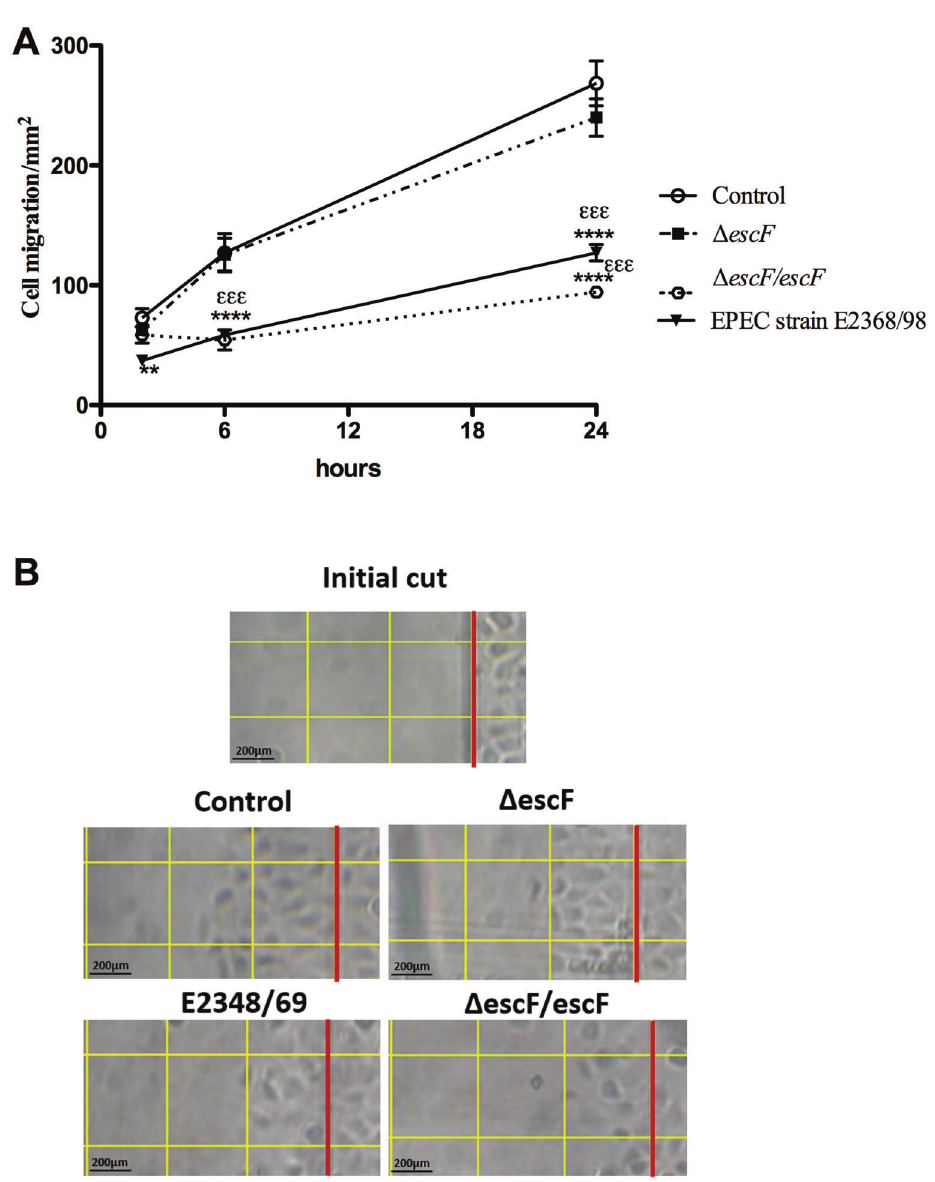
Figure 3. Effects of enteropathogenic Escherichia coli (EPEC) strain E2348/69, EscF-complemented ( D escF / escF ), and type III secretion system (T3SS)-deletion mutant ( D escF ) infection on migration of IEC-6 cells A . Data are reported as mean ± SE of three independent experiments (n=7). **P o 0.01 and ****P o 0.001 vs uninfected control; eee P o 0.001 vs D escF EPEC strain (ANOVA followed by Bonferroni ’ s post-test). B , Intestinal cell migration after 6 h. The red line represents the initial cut and each square has an area of 0.1 mm 2 . Magni fi cation 10 (cid:1) , bar: 200 m